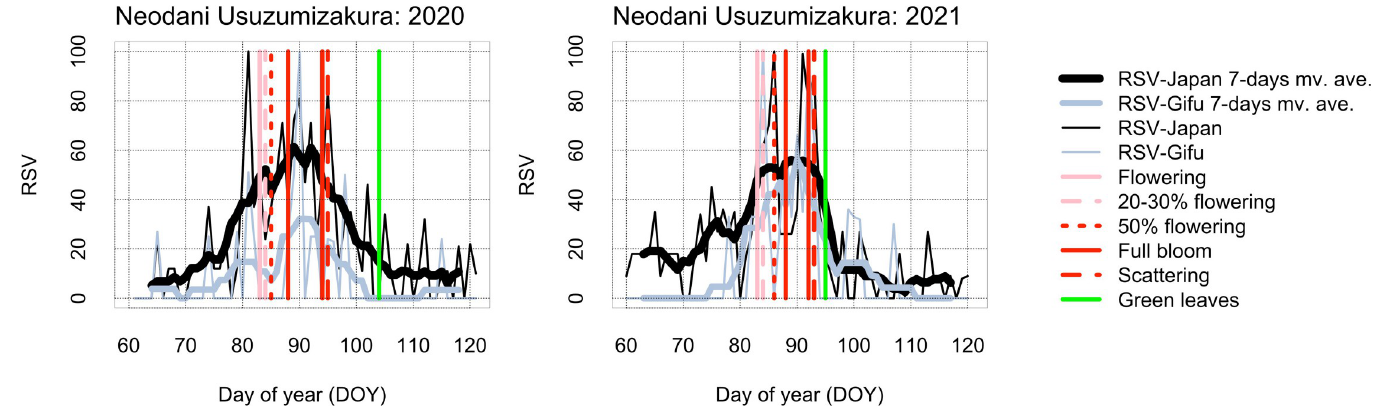
Fig 5. For Neodani Usuzumizakura, the relationship between time-series of RSV searched by “Topics” in all Japan and Gifu and flowering information published on websites from 2020 to 2021. For more result regarding the relationship from 2004 to 2019, see S3 Fig. mv. ave.: moving average.